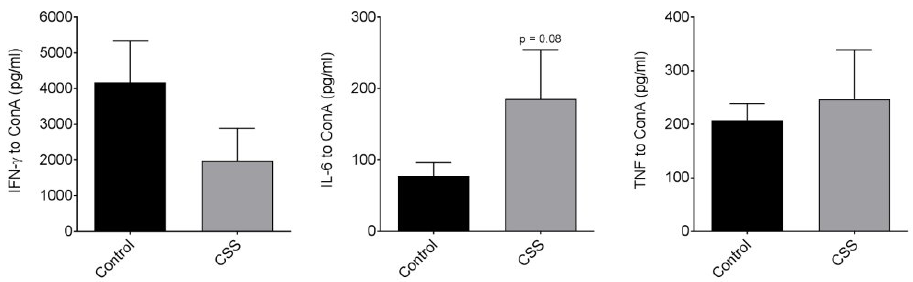
Figure 4. Differential effects of transgenerational stress on acquired and innate immune responses at the F2 generation. F2 rats were vaccinated with 1 × 10 6 CFU of M. bovis BCG subcutaneously, euthanized 8 weeks later, and splenocytes cultured with M. bovis culture filtrate protein (CFP) to assess antigen-specific T cell responses or with Concanavalin-A as a strong non-specific stimulant. The cultures from F2 CSS females produced less IFN- γ in response to BCG-specific stimulation and to non-specific stimulation with Concanavalin-A than F2 rats with no exposure to CSS. In contrast, a trend for increased IL-6 production was observed under identical conditions in the same cultures.